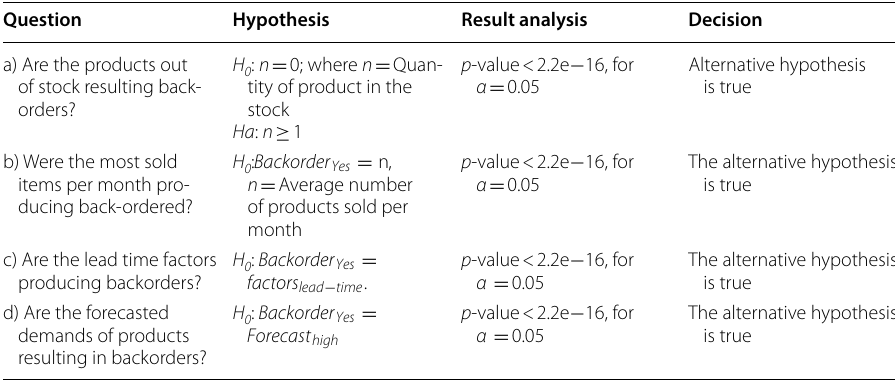
Table 2 Hypothesis testing